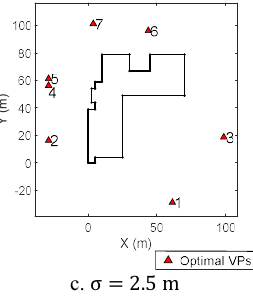
Figure 9. Solutions from the “Non-hierarchical + GA” strategy for CCIT: three resolutions corresponding to three levels of resolutions in Figure 8 are applied.